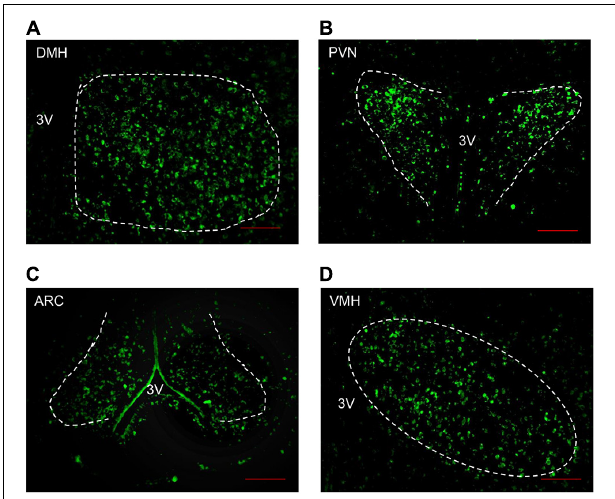
FIGURE 2 | Angptl8 expression in appetite-related nuclei in the hypothalamus. Angptl8 was expressed in the hypothalamic PVN (B) , DMH (A) , ARC (C) , and VMH (D) in normal mice on chow diet. Scale bar = 200 µ m.